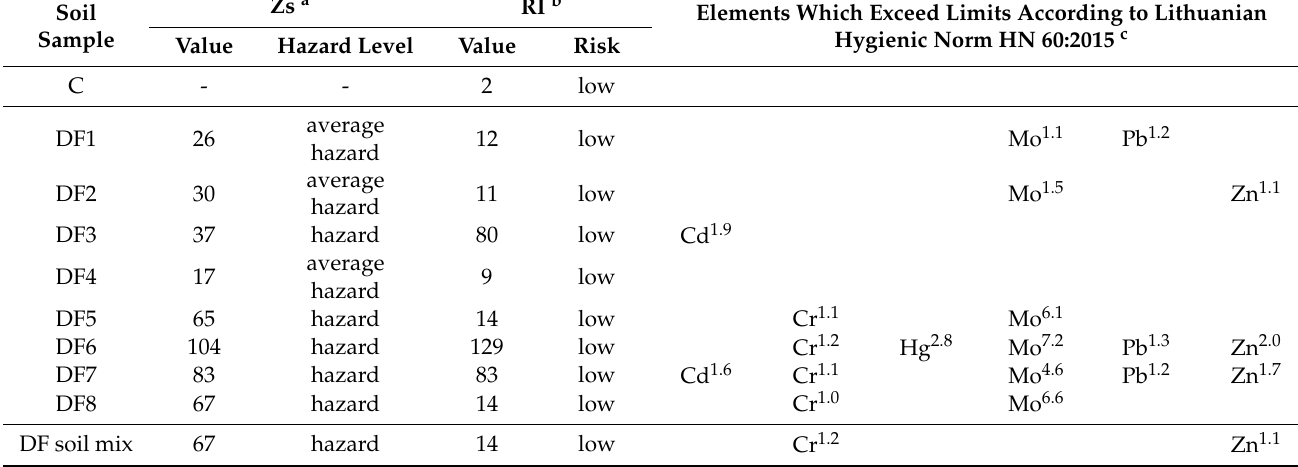
Table 1. Heavy metal content and hazard/risk of soil samples collected from the recultivated territory of a former drill